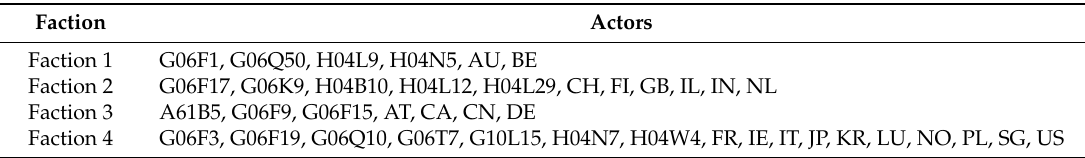
Table 6. Faction analysis